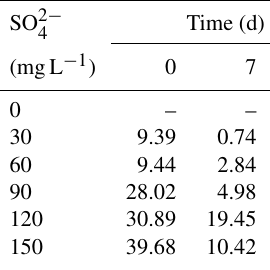
Table 1. Sulfate reduction rate in the water column of microcosms (mg(Ld) − 1